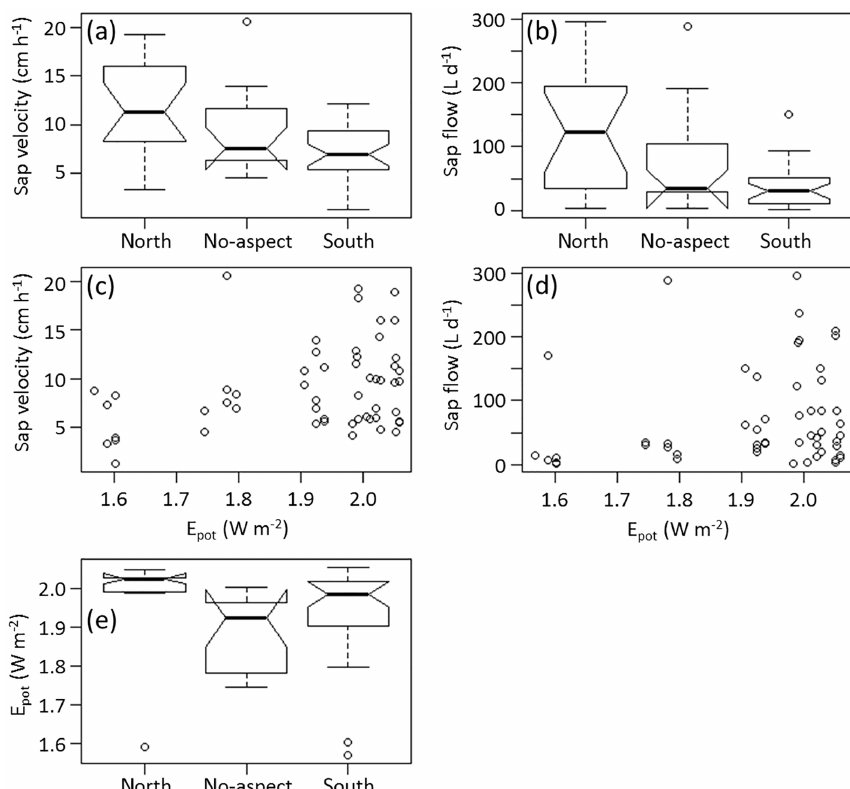
Figure A2. (a) Sap velocity and (b) sap flow values grouped according to aspect categories. (c) Sap velocities and (d) sap flow values of each tree with respect to E pot at the tree location. (e) E pot values at the tree locations values grouped according to aspect categories. Shown are temporal averages, for each tree (for sap velocity and sap flow) or each tree site (for E pot ) . The uncharacteristically high sap flow values are probably due to overestimation during the upscaling to tree-level transpiration and should be treated with caution; however, absolute values are not of interest here, rather relations and spatial patterns which should be